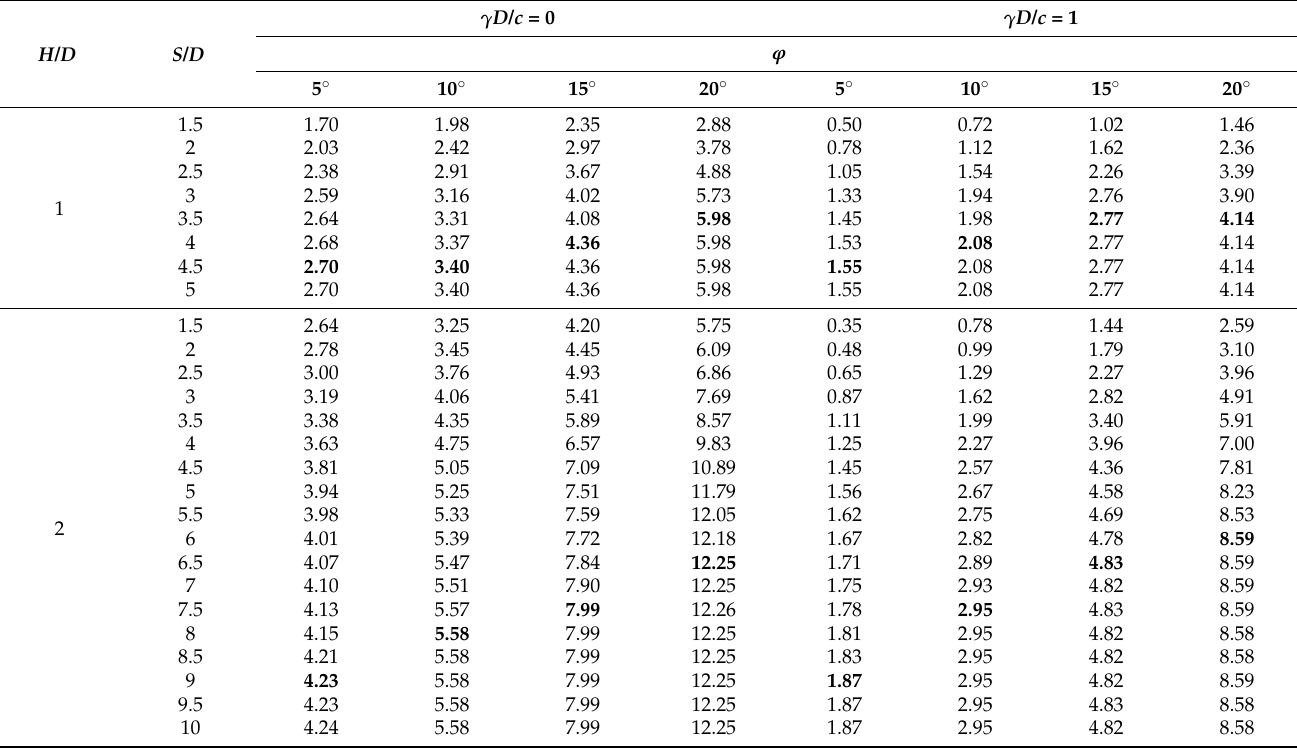
Table 3. Seismic bearing capacity N cs with k h =